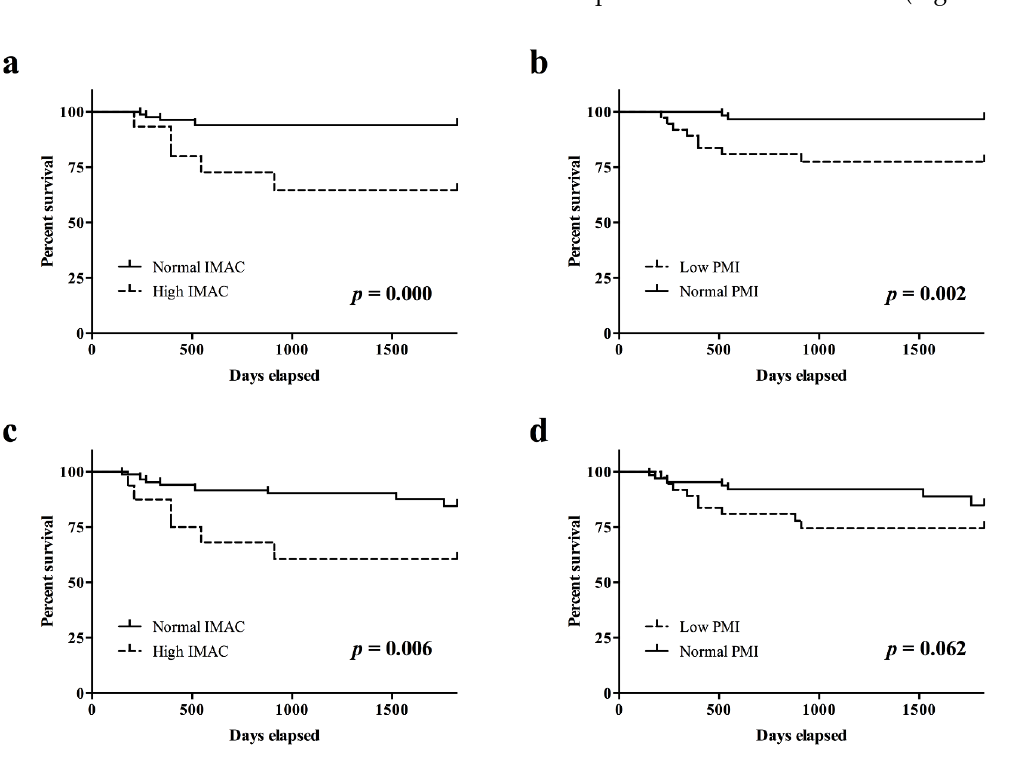
Figure 2. Survival rates according to preoperative IMAC and PMI. ( a ) The disease-specific